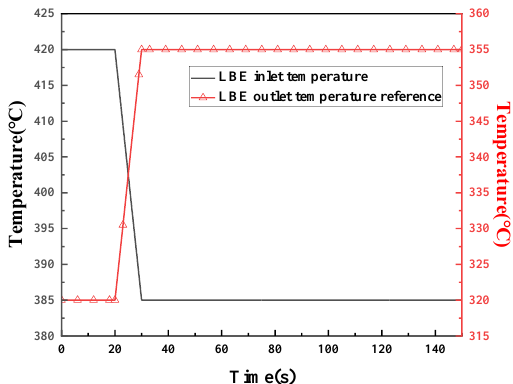
Figure 15. Change in LBE temperature at OTSG inlet during load shedding.